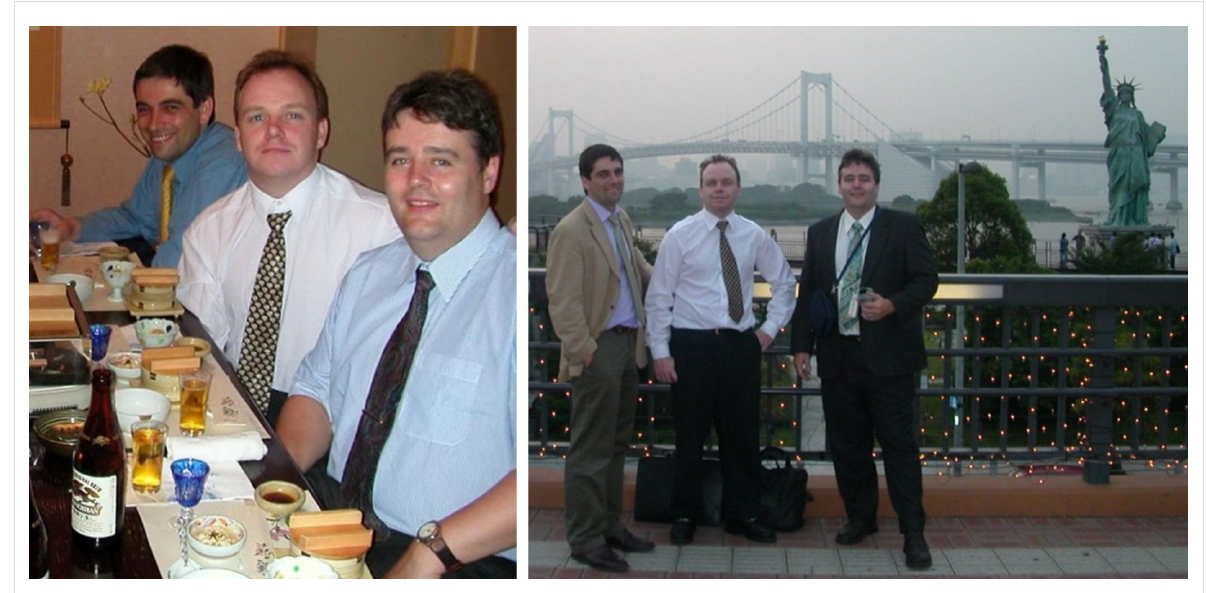
Figure 13: With Matthew Davidson and Steven Bull during “World Cup” lecture tour of Japan in 2002. (Left) Private photo taken in Osaka. (Right) Photo taken in Tokyo by Katsuhiko Ariga.